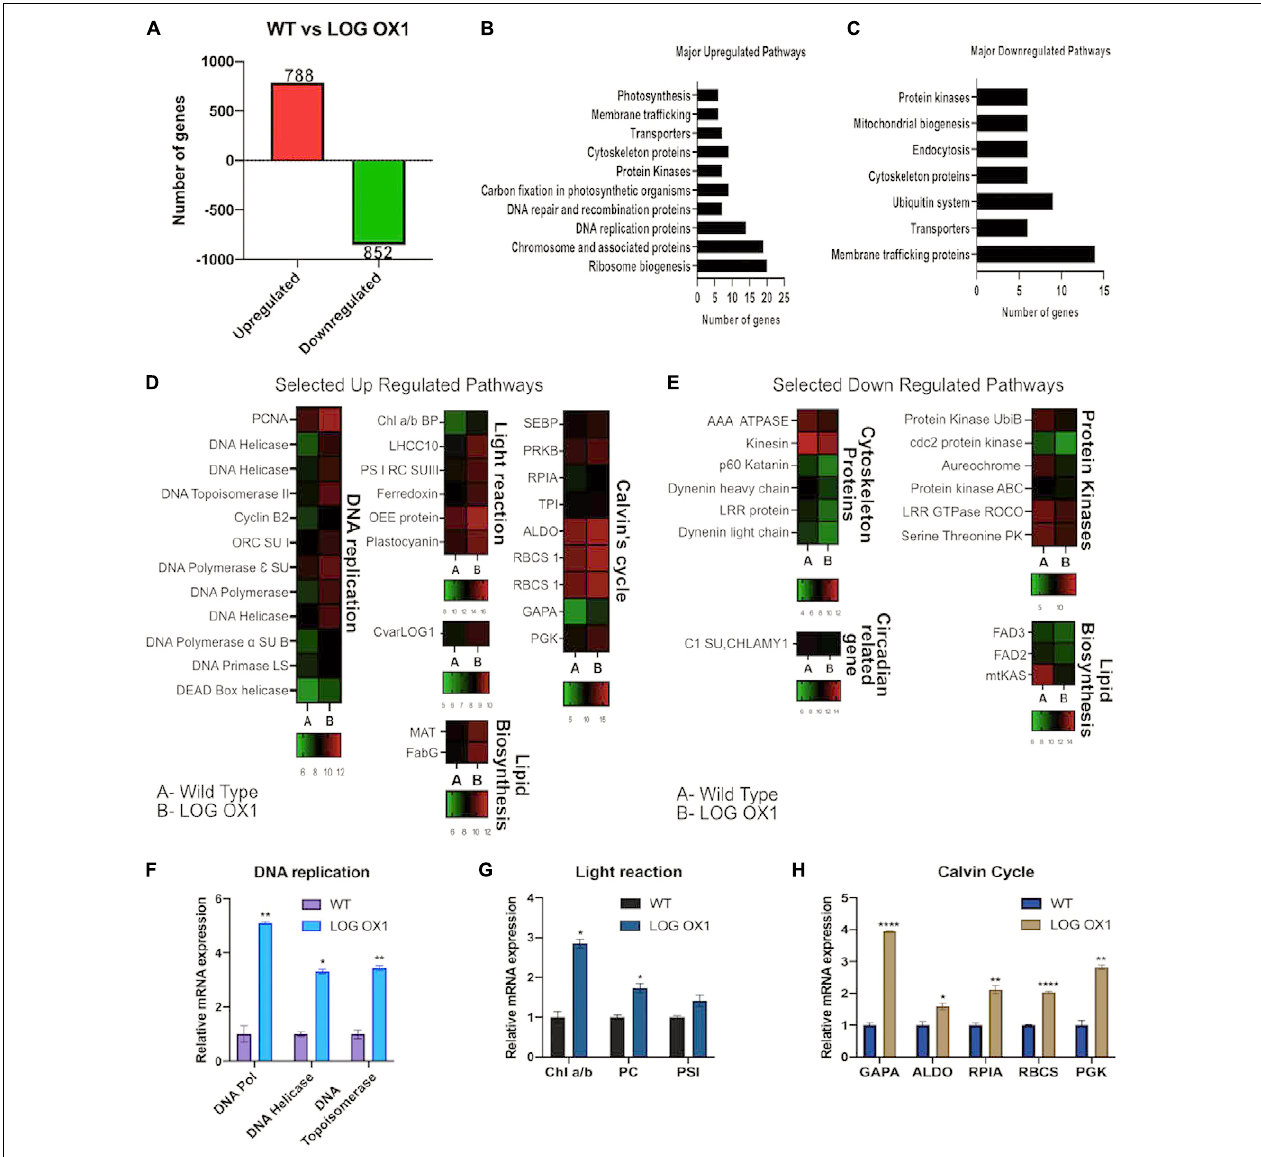
FIGURE 7 | RNA-Seq based comparison of LOG OX1 and WT transcriptome at 14 days post inoculation. (A) Total number of differentially expressed genes (1.5 fold) in LOG OX in contrast to the wild type; upregulated genes (red) and downregulated genes (green) (FDR ≤ 0.05, n = 3). (B) Major upregulated pathways in LOG OX1 in comparison to WT. (C) Major downregulated pathways in LOG OX1 in comparison with WT. (D) Heat maps of selected upregulated pathways in LOG OX1; color bars below each sub-panel represent the range of expression values in log 2 . (E) Heat maps of selected downregulated pathways in LOG OX1; color bars below each sub-panel represent the range of expression values in log 2 . Real-time quantitative PCR validation of RNA Seq data for selected genes from (F) DNA replication. (G) Light reaction of photosynthesis. (H) Dark reaction of photosynthesis; bars indicate ± SE ( n = 3). For all graphs, data significant at **** P ≤ 0.0001, ** P ≤ 0.01, and * P ≤ 0.05 compared with the wild type using Student’s t